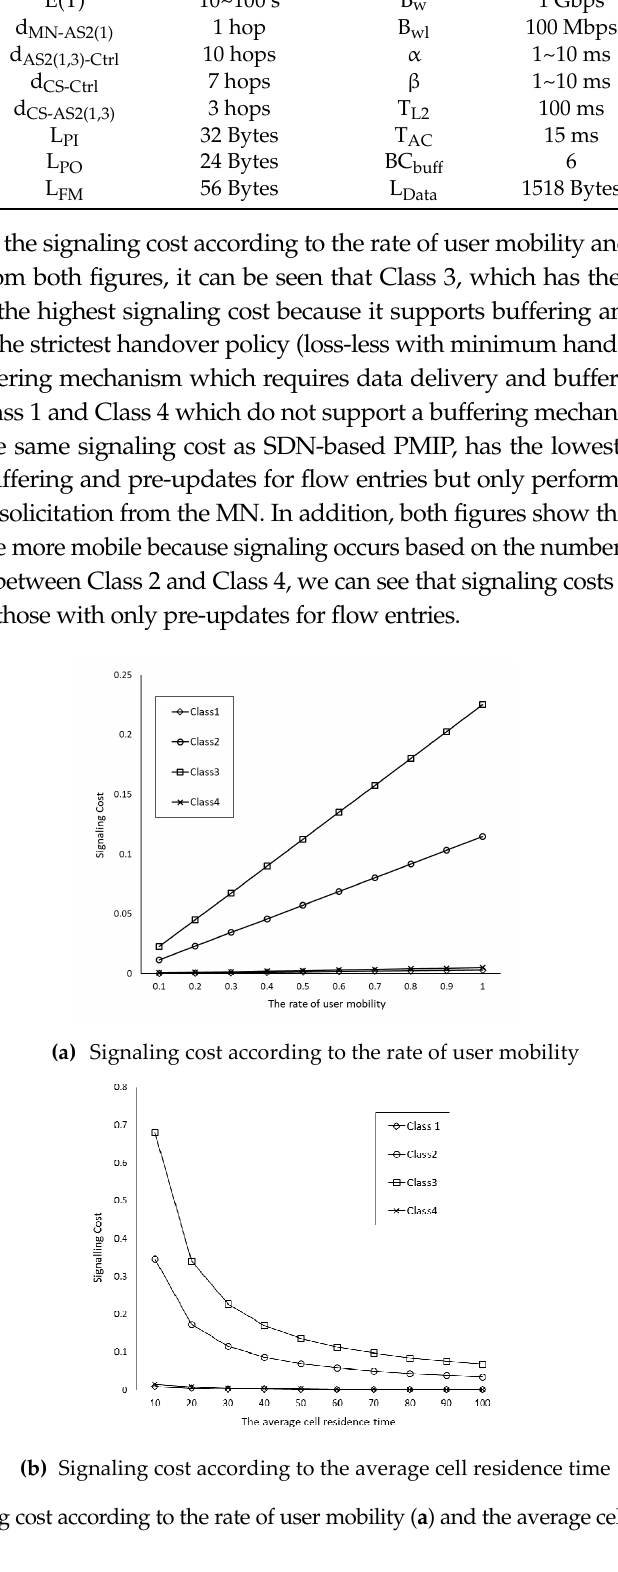
Table 3. Parameter values.